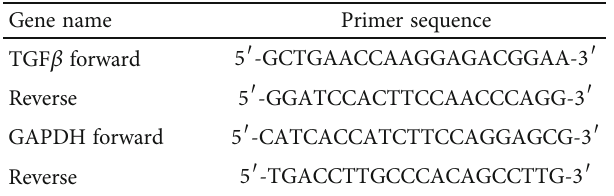
Table 1: The primers used for quantitative